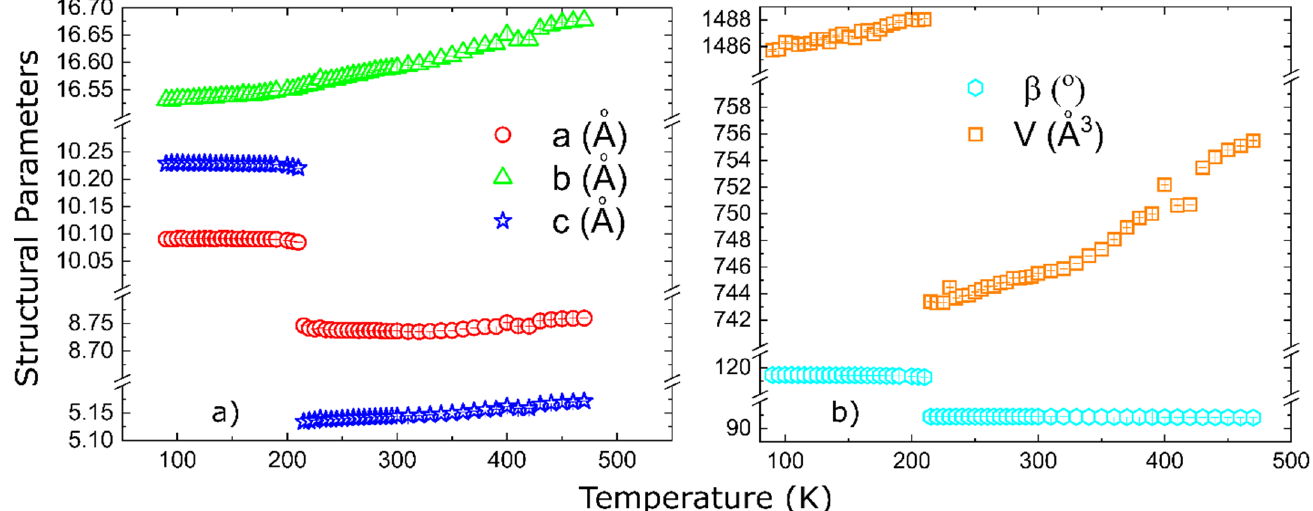
Figure 9. Temperature dependent lattice parameters: panel ( a ) shows the lattice parameters, while panel ( b ) shows the monoclinic angle and the unit cell volume.